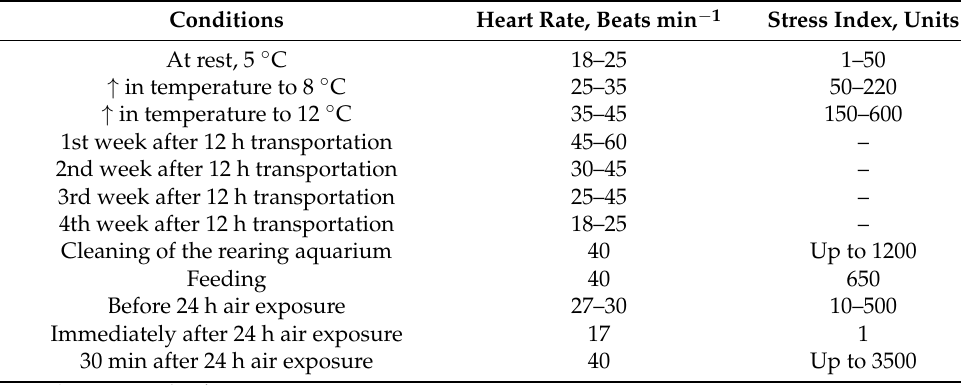
Table 2. Cardiac activity of red king crabs Paralithodes camtschaticus under different conditions (adopted from [102]).